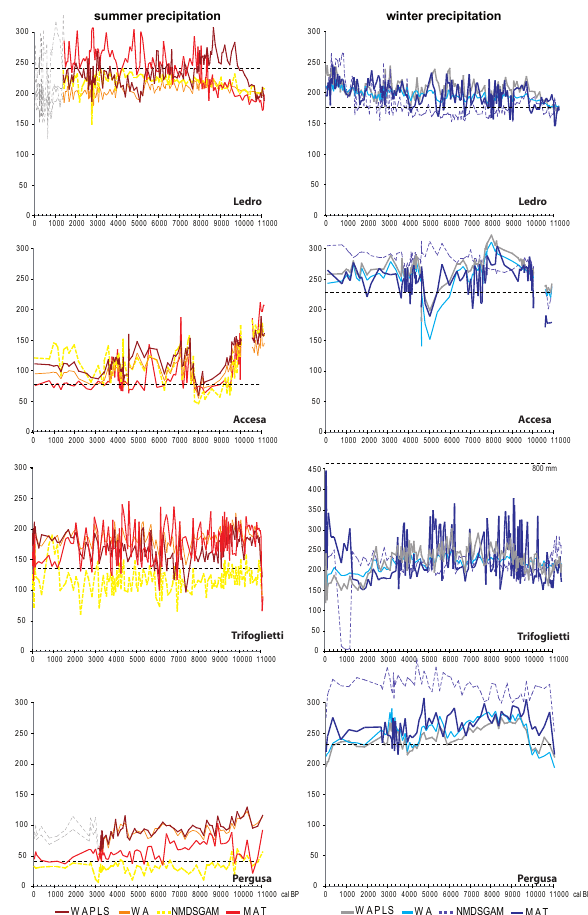
Fig. 4. Pollen-based seasonal precipitation (winter=sum of Decem- ber, January, February precipitation, and summer=sum of June, July, August precipitation, in mm) values for the four lakes esti- mated with the methods listed in Fig. 3. Modern values are indi- cated with a horizontal grey dotted line. The thin dotted grey curve (summer precipitation, Ledro and Pergusa) corresponds to unrealis- tic